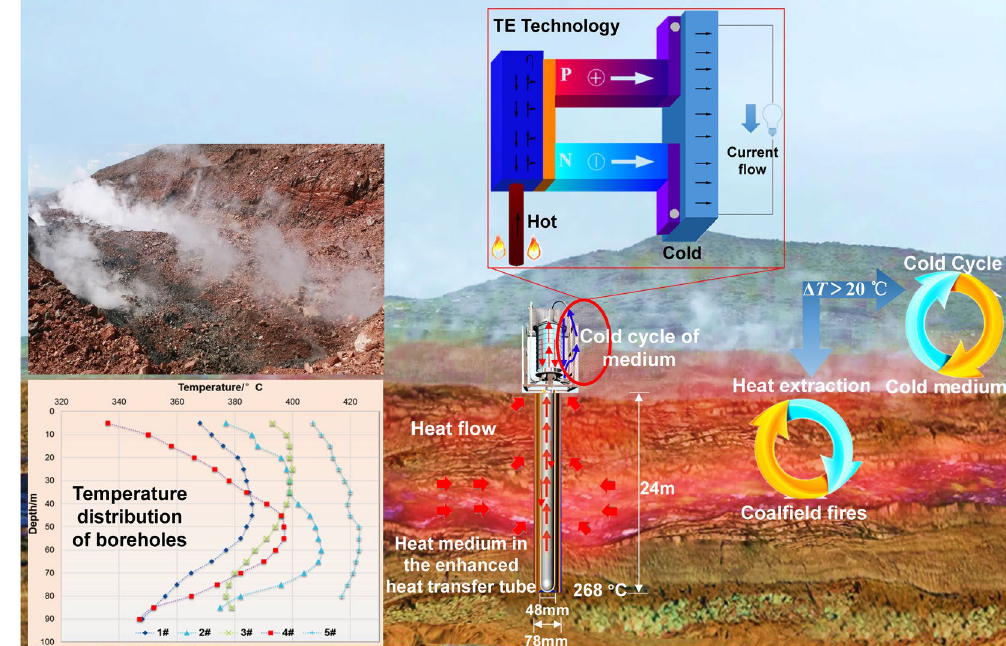
Figure 2. Illustration of clean power generation from the thermal energy of coal fires. (This figure was created by Microsoft Office 2016 Pro Plus. Link: